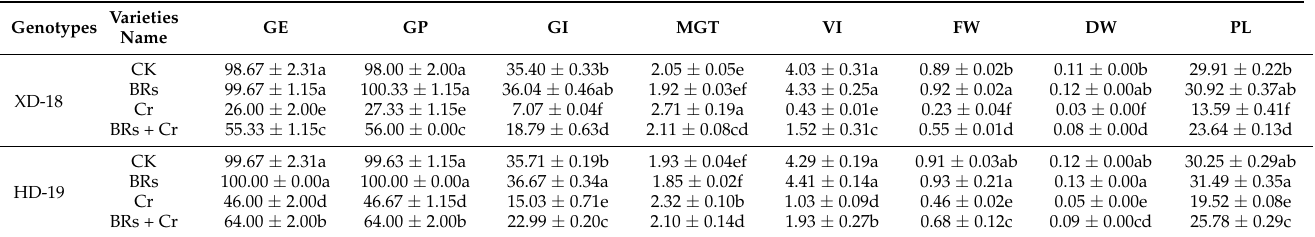
Table 1. Foliar application of BRs regulates the various germination and growth parameters in two different soybean genotypes such as germination index (%), germination percentage (%), mean germination time (%), biomass (fresh-FW and dry-DW weights), and plant length (PL) with/without Cr stress